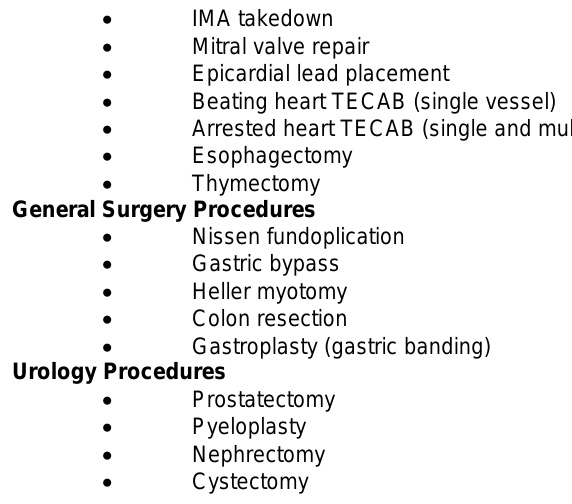
Procedures Performed by Robotic Surgery Cardiac